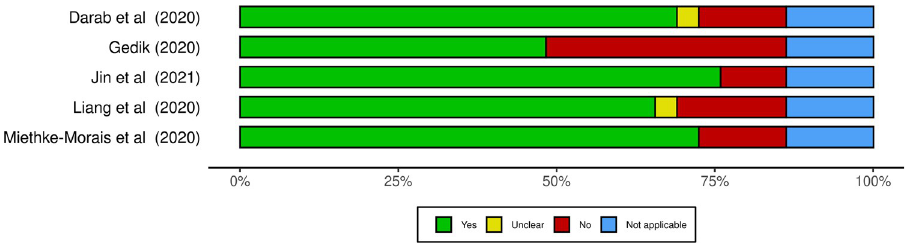
Fig 3. Methodology assessment of included studies based on the checklist provided by Oliveira, Itria and Lima [8]. Graphic produced with robvis , provided by McGuinnes and Higgins [17].